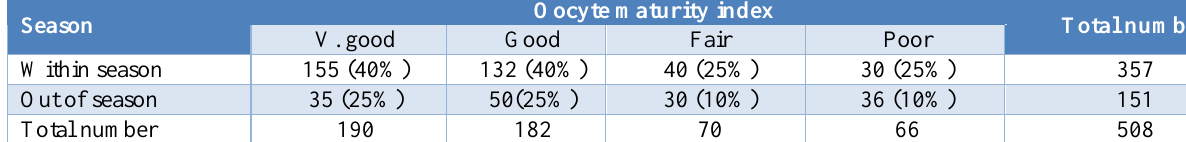
Table, 6: Oocytes maturity index within and out of season.